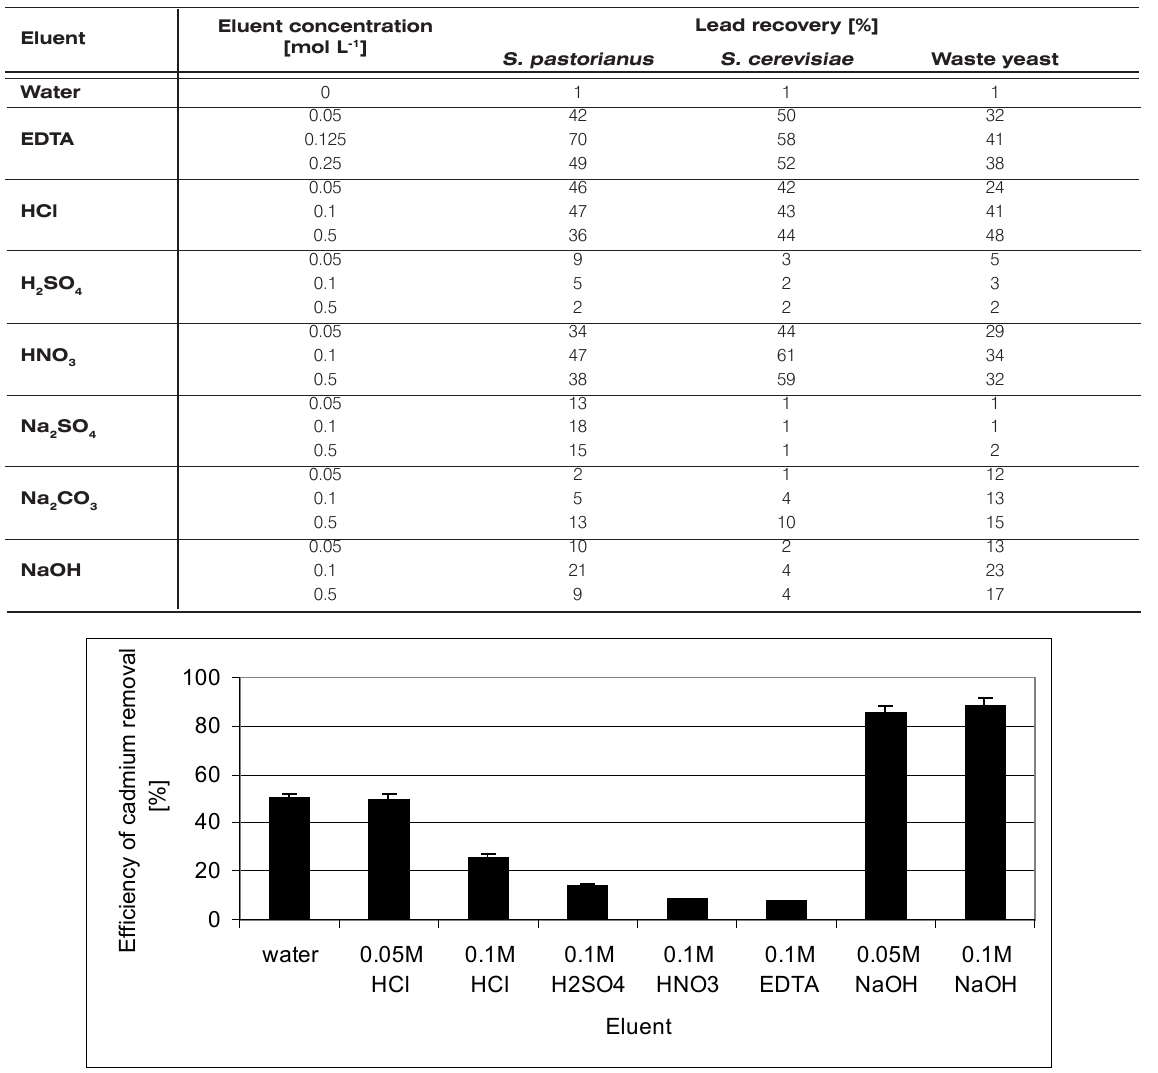
Figure 1. The efficiency of cadmium removal by S. pastorianus in the second biosorption process after previous desorption with 10 mL of various eluents (presented values are the mean of three replicates with standard